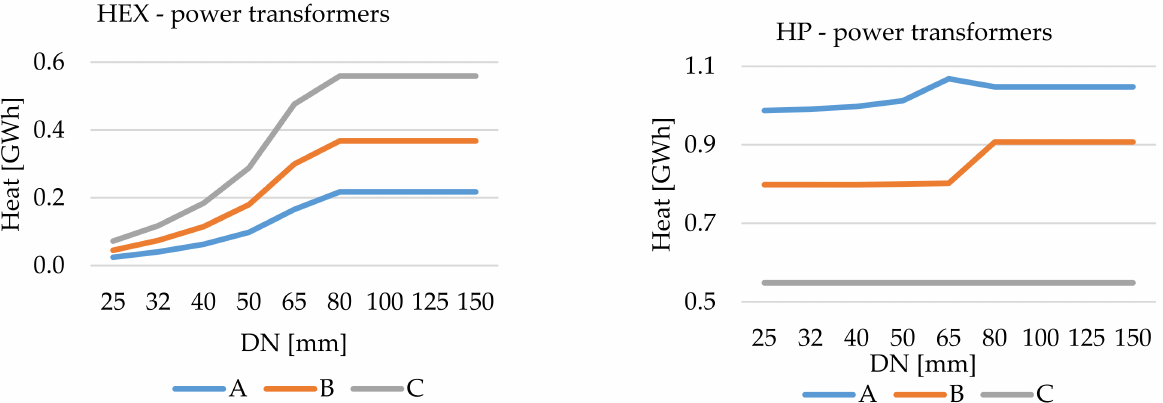
Figure 17. Waste heat from power substations injected into the DH network in relation to the connection pipe size, DH temperature regimes, and utilization technology: ( Left ) Heat exchanger; ( right ) heat pumps.